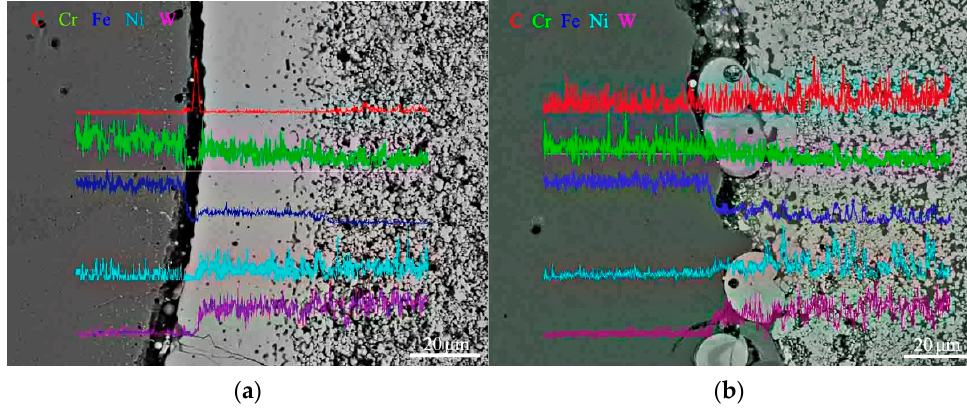
Figure 5. Composite interface line scan with ( a ) no Ni added and ( b ) Ni added.